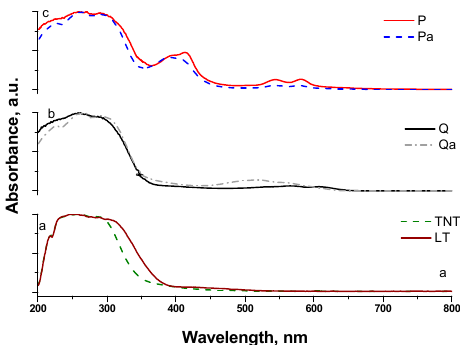
Figure 3. UV-Vis diffuse reflection spectra of the analyzed photocatalysts. ( a ) TiO 2 powders and nanotubes without sensitizers; ( b ) TiO 2 sensitized with Quinizarin and ( c ) TiO 2 sensitized with Zinc protoporphyrin.